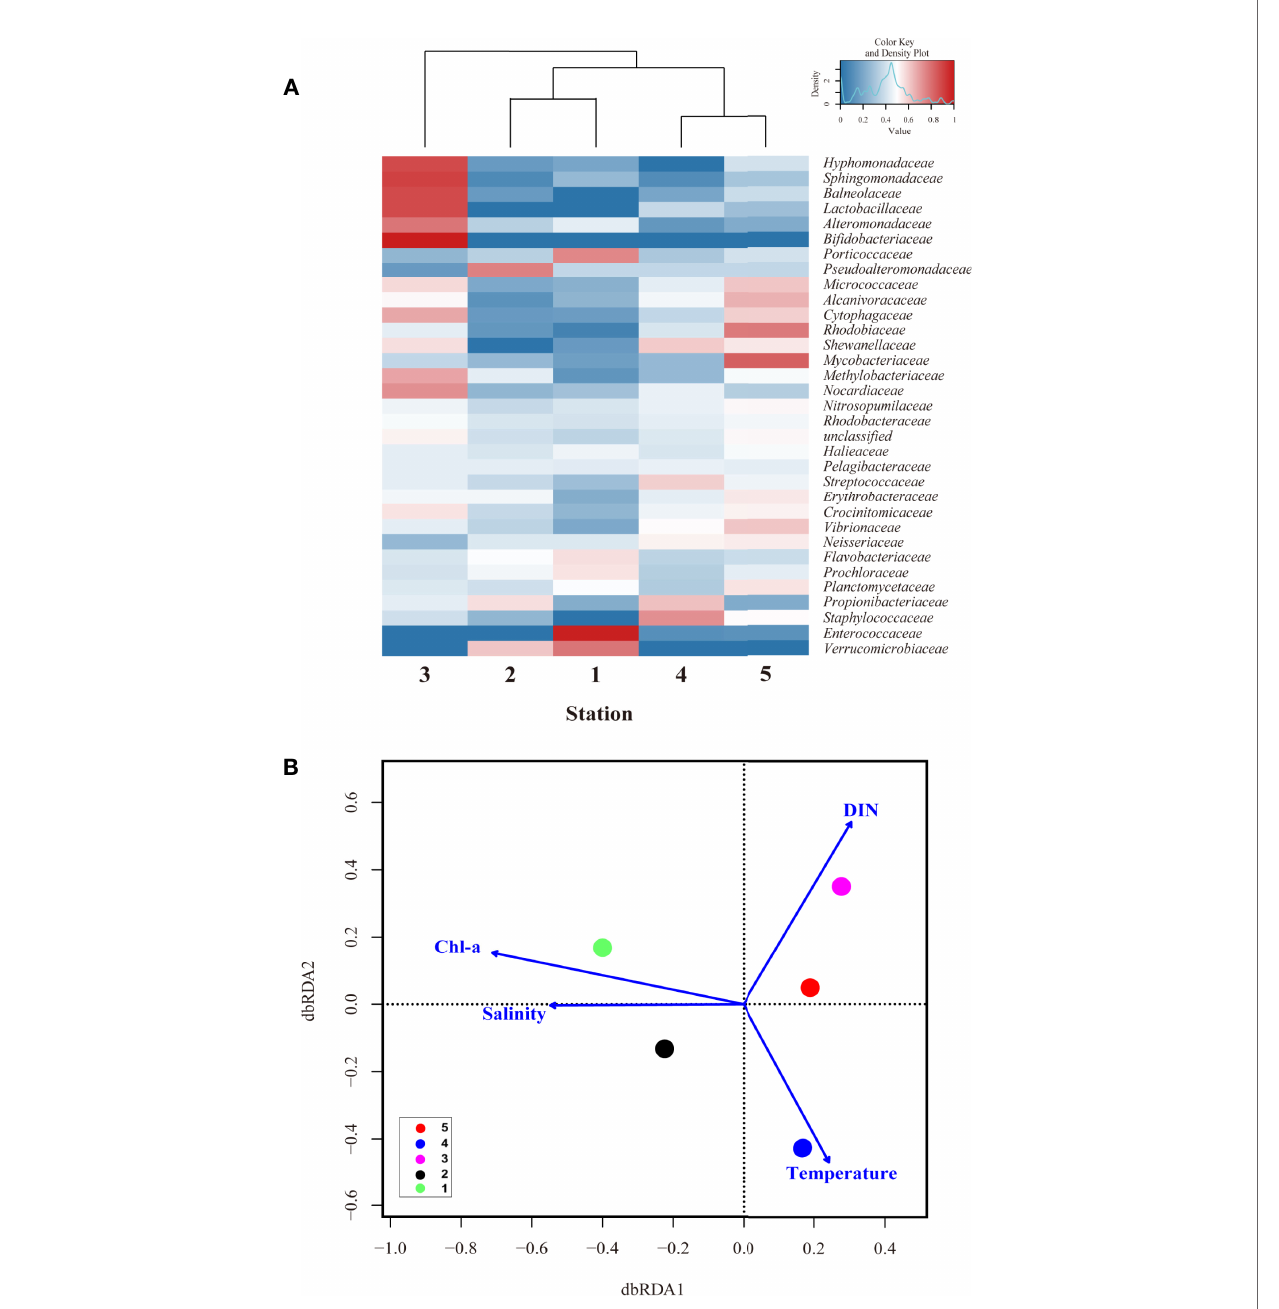
FIGURE 7 | The distance-based redundancy analysis (dbrda) ordination plot and heatmap revealed that environmental conditions controlled the surface bacterial community composition in wintertime of UB. (A) hierarchical heatmap showing the relative abundance at family level (33 genera) in fi ve stations. Color codes indicate the relative abundance, ranging from blue (low relative abundance) to red (high relative abundance); and (B) the dbrda ordination diagram of bacterial communities based on OTU at family level with related physical and biogeochemical factors, including temperature, salinity, dissolved inorganic nitrogen (DIN), and phosphate (PO 4 )